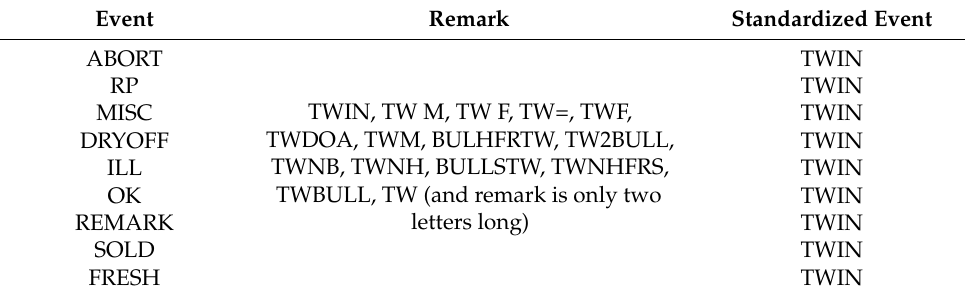
Table 1. Standardization and collapsing of on-farm terminology used to record TWIN events analyzed in this study. All such combinations were collapsed into TWIN (1). The absence of these combinations resulted in the cow being classified as having a standard, singleton pregnancy